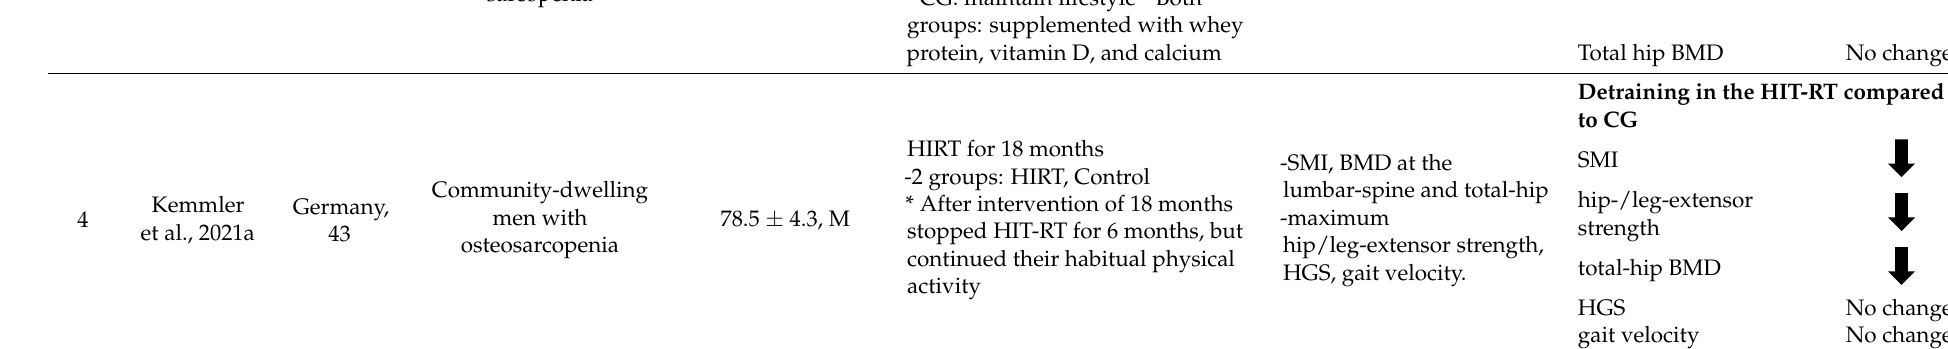
Table 1. Effect of exercise on subjects with cancer and baseline measurement of sarcopenia.